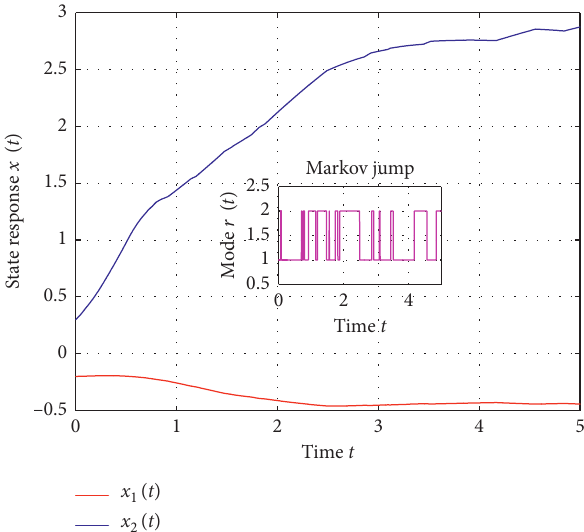
Figure 1: Curve of x ( t ) for Example 1 without any control.